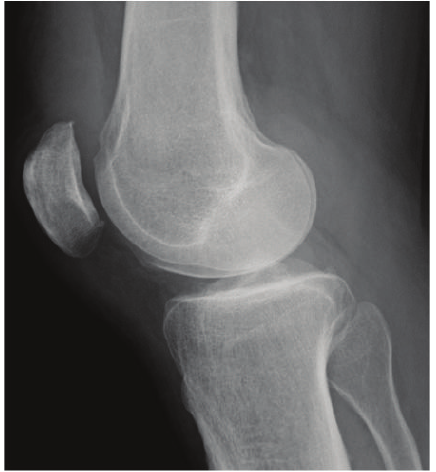
Figure 2: Lateral plain radiograph. Osteophyte formation was observed in the upper pole of the